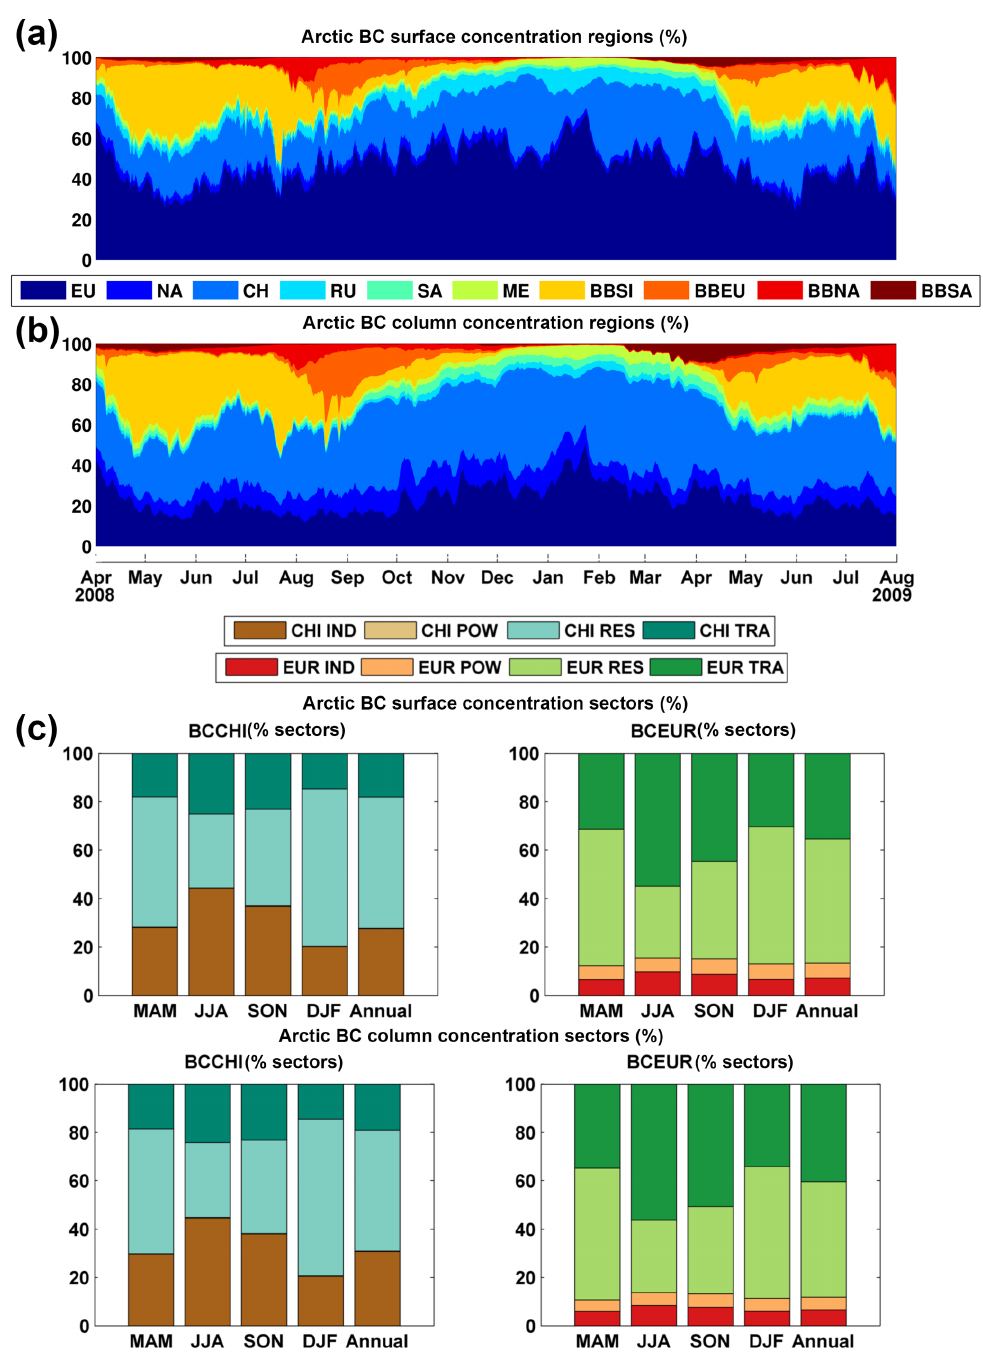
Figure 12. Panels (a, b) show the seasonality of BC major geographical contributors to the Arctic (latitudes >60 ◦ N) surface (first row) and column (second row) concentrations. The bar plots (c) indicate the seasonality and annual average of contributions of various economic sectors from Europe or China to the Arctic (latitudes >60 ◦ N) surface (third row) or column (bottom row) BC concentration. BBSI, BBEU, BBNA, and BBSA denote biomass burning from Russia, Europe, North America, and south Asia, respectively. EUR and CHI denote Europe and China. Industry, power, residential, and transportation sectors are represented with IND, POW, RES, and TRA acronyms. MAM denotes the average for the months of March, April, and May. JJA denotes the average for the months of June, July, and August. SON (bottom right panel) denotes average for the months of September, October, and November. DJF denotes the average for the months of December, January, and February (last access: 13 November